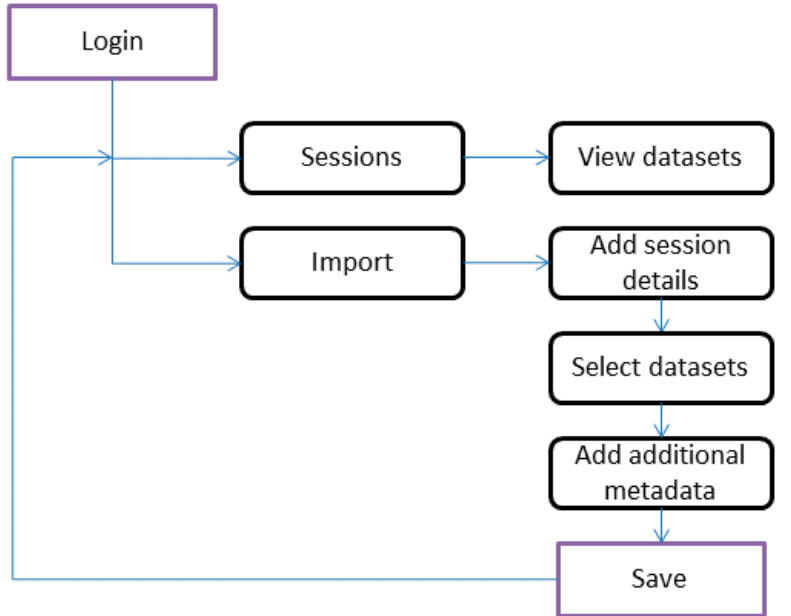
Figure 4. Illustration of a typical user workflow and application for aggregation of inhomogeneous datasets.